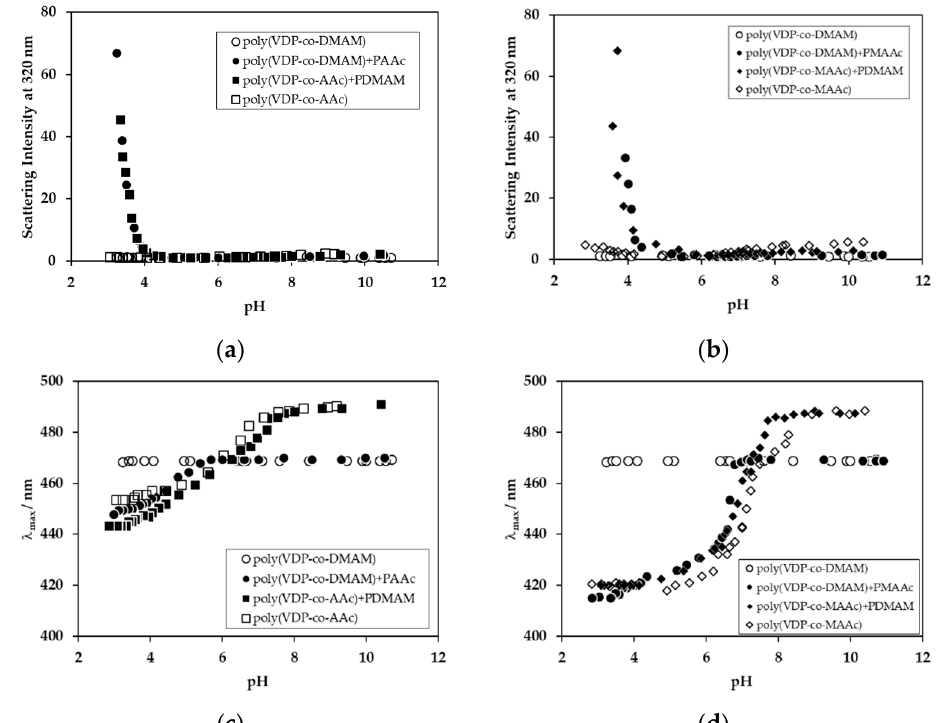
Figure 5. Scattering intensity at 320 nm ( a , b ) and fluorescence λ max values ( c , d ) as a function of pH: PolyDMAM and polyAAc mixed systems ( a , c ) and polyDMAM and poly(methacrylic acid) (polyMAAc) mixed systems ( b , d ).